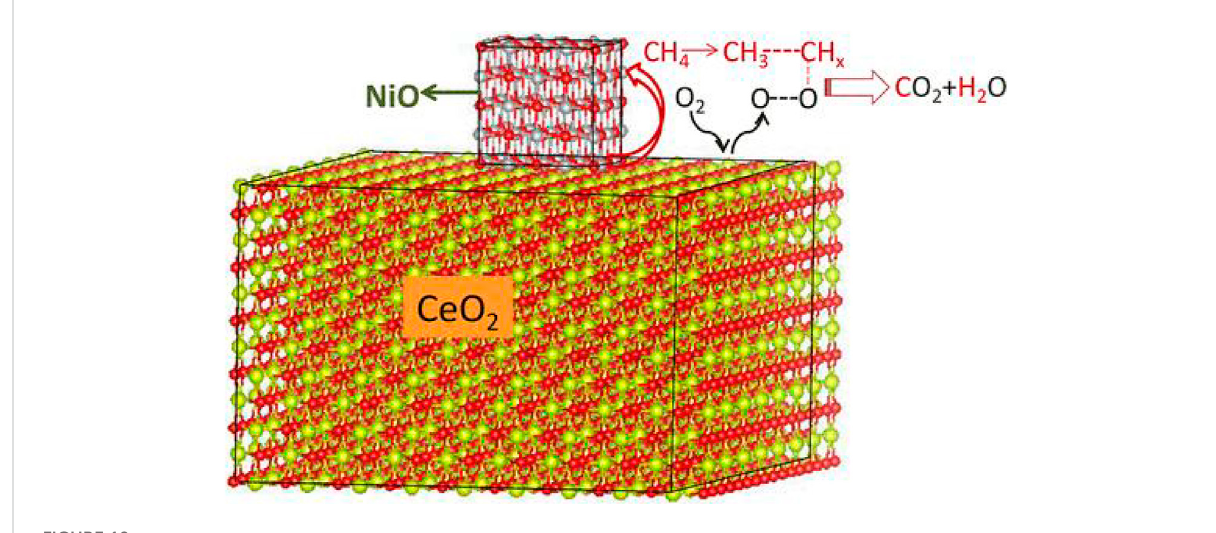
FIGURE 10 Schematic brie fl y showing activations of C – H of CH 4 and O − O of O 2 and coupling between CH x species and atomic oxygen at the interface of NiO/CeO 2 . Reprinted with permission from Zhang et al. (2018). Copyright (2018) American Chemical